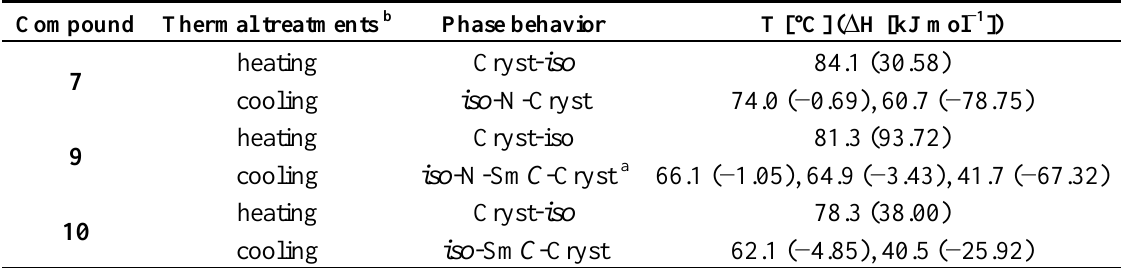
Table 1. Phase behaviors of compounds 7 , 9 and 10